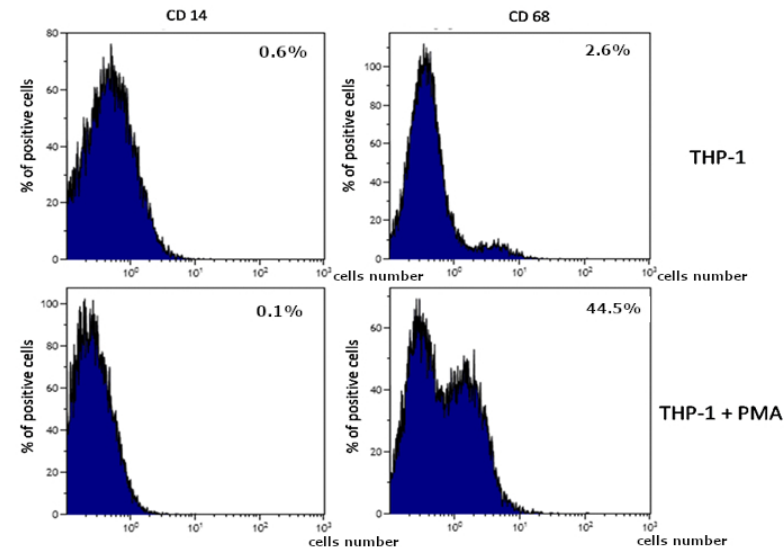
Figure 2. The effect of Biodentine TM on the activation of THP-1 monocytes. THP-1 monocytic cells were incubated in the presence of Biodentine without phorbol 12-myristate 13-acetate (PMA ( upper quadrants ) and treated with PMA ( lower quadrants ). Expression was determined by flow cytometry. CD68 expression (marker for macrophage differentiation) increased after 48 h treatment with PMA (200 nM) as compared to non-treated cells. Expression of CD14 (marker for monocyte differentiation) did not change significantly, p = 0.65 (U Mann-Whitney test). cells number.